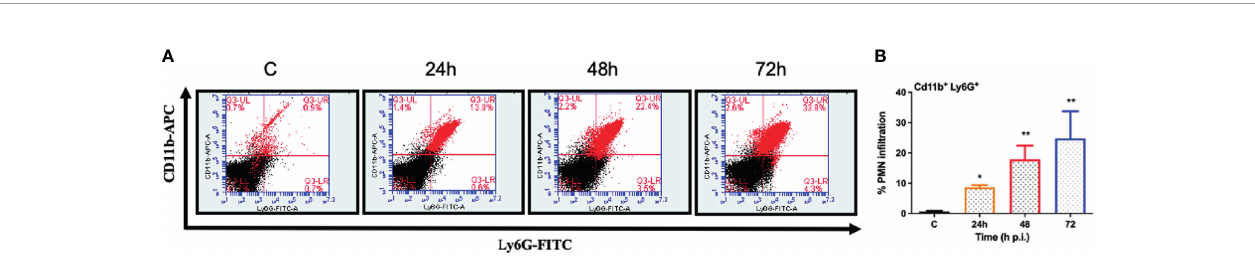
FIGURE 4 | S. epidermidis induces PMN in fi ltration in C57BL/6 mice eyes. C57BL/6 mice eyes (n = 6 eyes) were infected by intravitreal injection of S. epidermidis (10 7 cfu/eye). Eyes with PBS injection harvested at 72 h p.i. were used as control. At indicated time points, retinas were harvested, and single-cell suspensions were stained with anti-CD45-PECy5, anti-CD11b-APC, and anti-Ly6G-FITC antibodies. (A) The representative dot plots indicate S. epidermidis induced retinal PMN (CD11b-Ly6G double-positive) in fi ltration. (B) The bar graph represents the percentage of neutrophil in fi ltration at different time intervals with respect to control eyes set at 100%. Statistical analysis was performed using ANOVA with Dunnett ’ s multiple comparison test (B) , (*) p<0.05 (**) p<0.01 ns, nonsigni fi